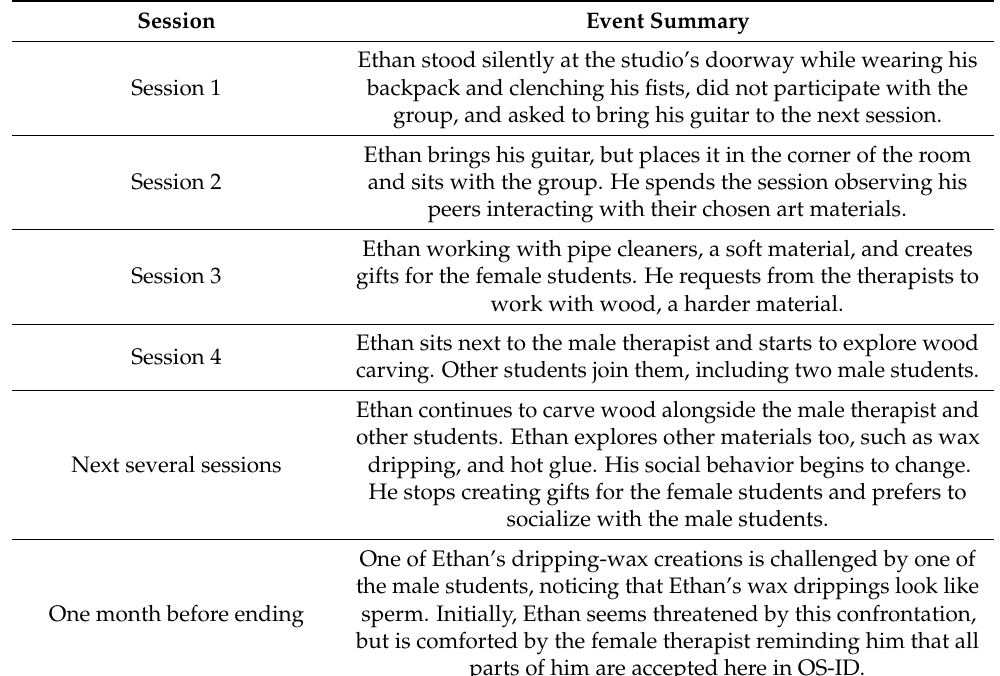
Figure 1. Ethan’s wax drippings on Bristol board. Table 3. Summary of Ethan’s ten-month OS-ID